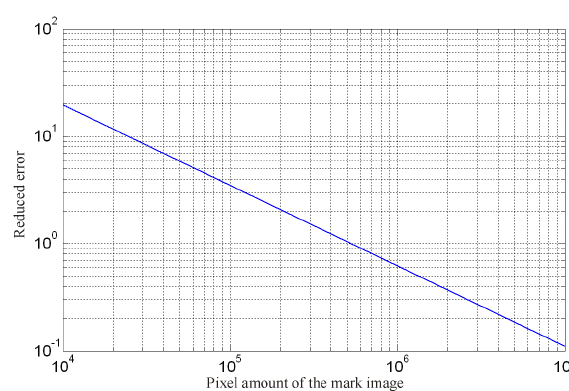
Fig. 6. The reduced measurement error of vibrational displacement as a function of the round mark image area.